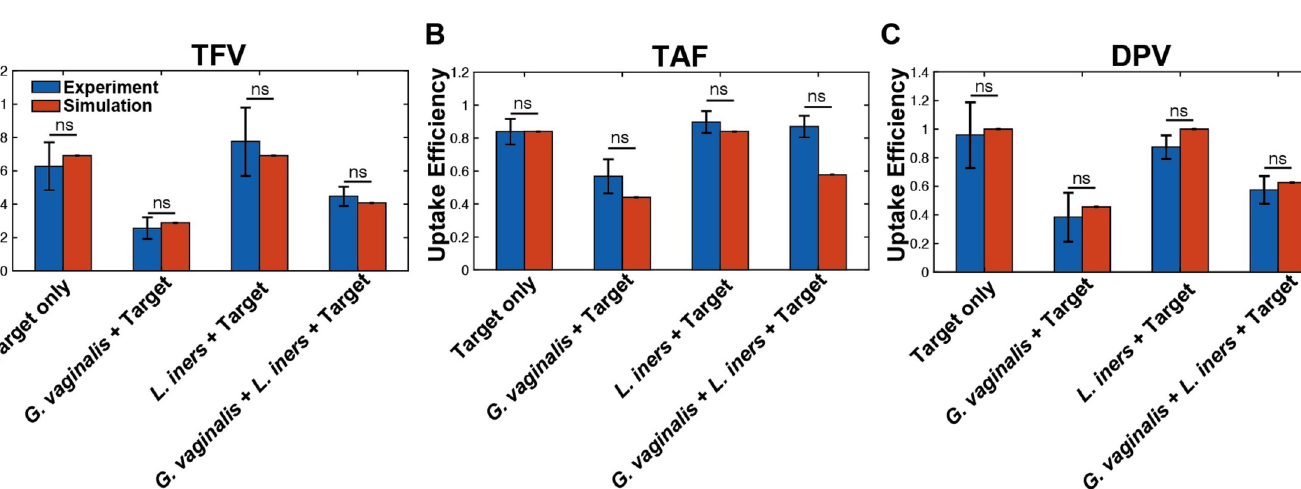
PLOS Pathogens| https://doi.org/10.1371/journal.ppat.1009024 December 3,